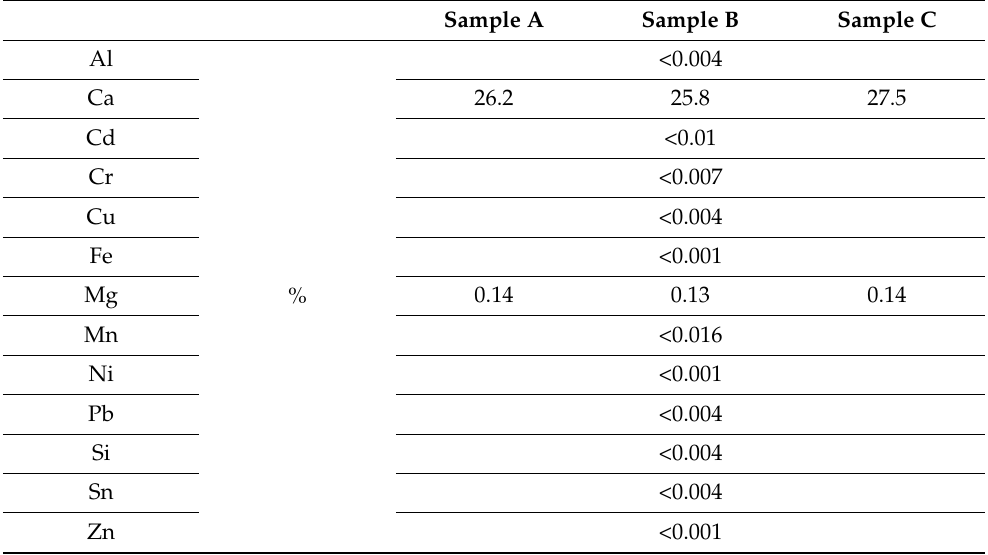
Table 1. Content of selected elements in calcite samples.